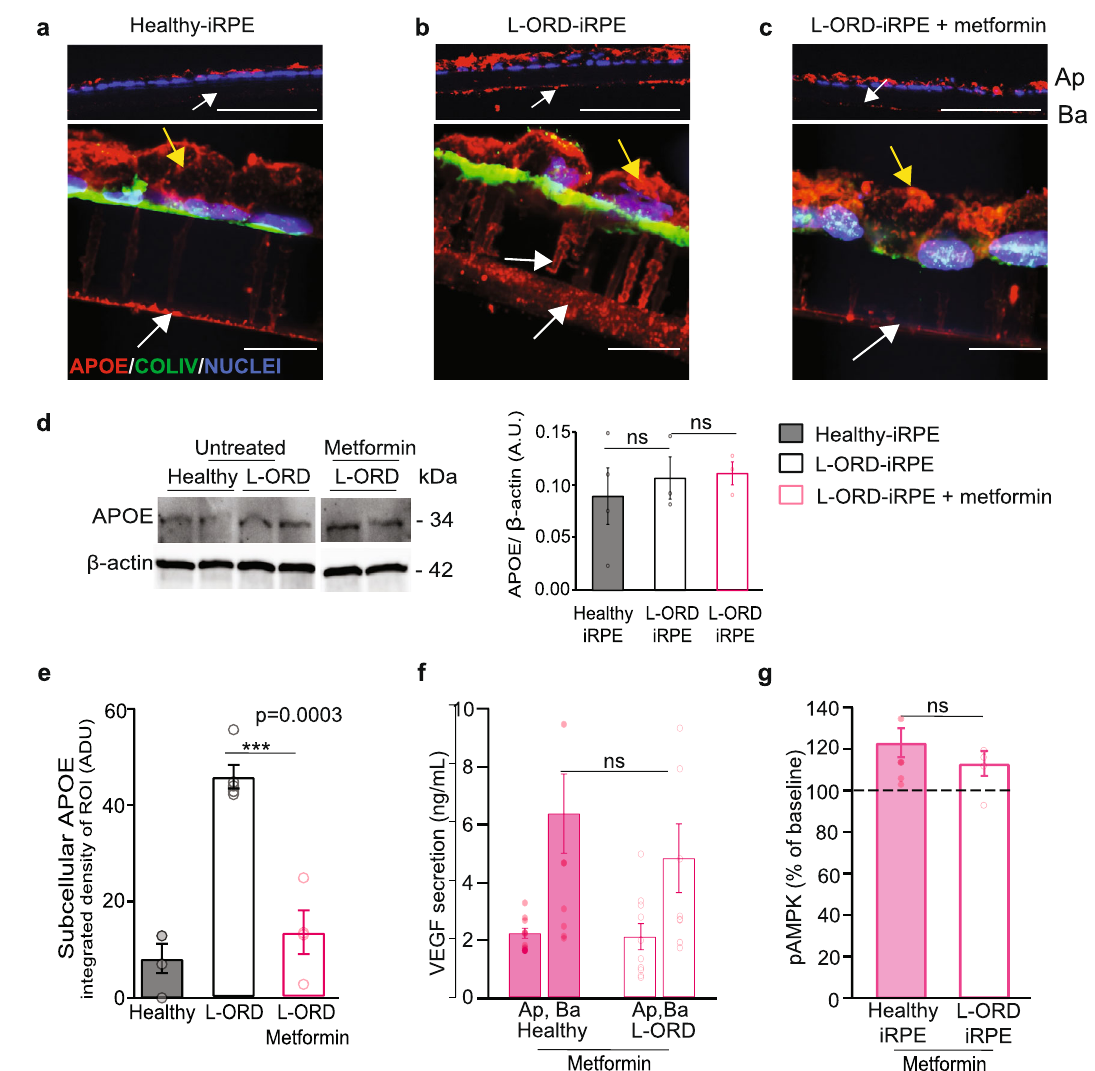
Fig. 6 Metformin ameliorates L-ORD cellular phenotypes. a – c Immuno fl uorescent images of cryosectioned healthy ( a ) and L-ORD-iRPE [without metformin ( b ), with metformin ( c )] monolayers fed POS for 7 consecutive days and stained for APOE (red), COLLAGEN IV (COLIV, green), nuclei with Hoechst 33342 (blue). Top panels ( a – c ) show 20x magni fi cation images, scale bar: 50 µ m. Representative 60x magni fi cation images are shown in bottom panels ( a – c ), scale bar: 10 µ m. Apical APOE is indicated with yellow arrows and basal with white arrows ( n = 4) d Representative Western blot and quanti fi cation of APOE signal in healthy ( n = 4) and L-ORD-iRPE without ( n = 3) and with metformin treatment ( n = 3). e Quanti fi cation of APOE signal from images shown in panels a – c . ( n = 4 for healthy-iRPE; n = 5 for L-ORD-iRPE; n = 4 for L-ORD-iRPE with metformin). f ELISA-based measurements of apical and basal VEGF secretion in metformin-treated healthy and L-ORD-iRPE ( n = 10; Ap: 2.07 ± 0.4; Ba: 4.8 ± 1). g pAMPK levels in response to AICAR (2 mM) in L-ORD-iRPE ( n = 6) treated with metformin, measured by